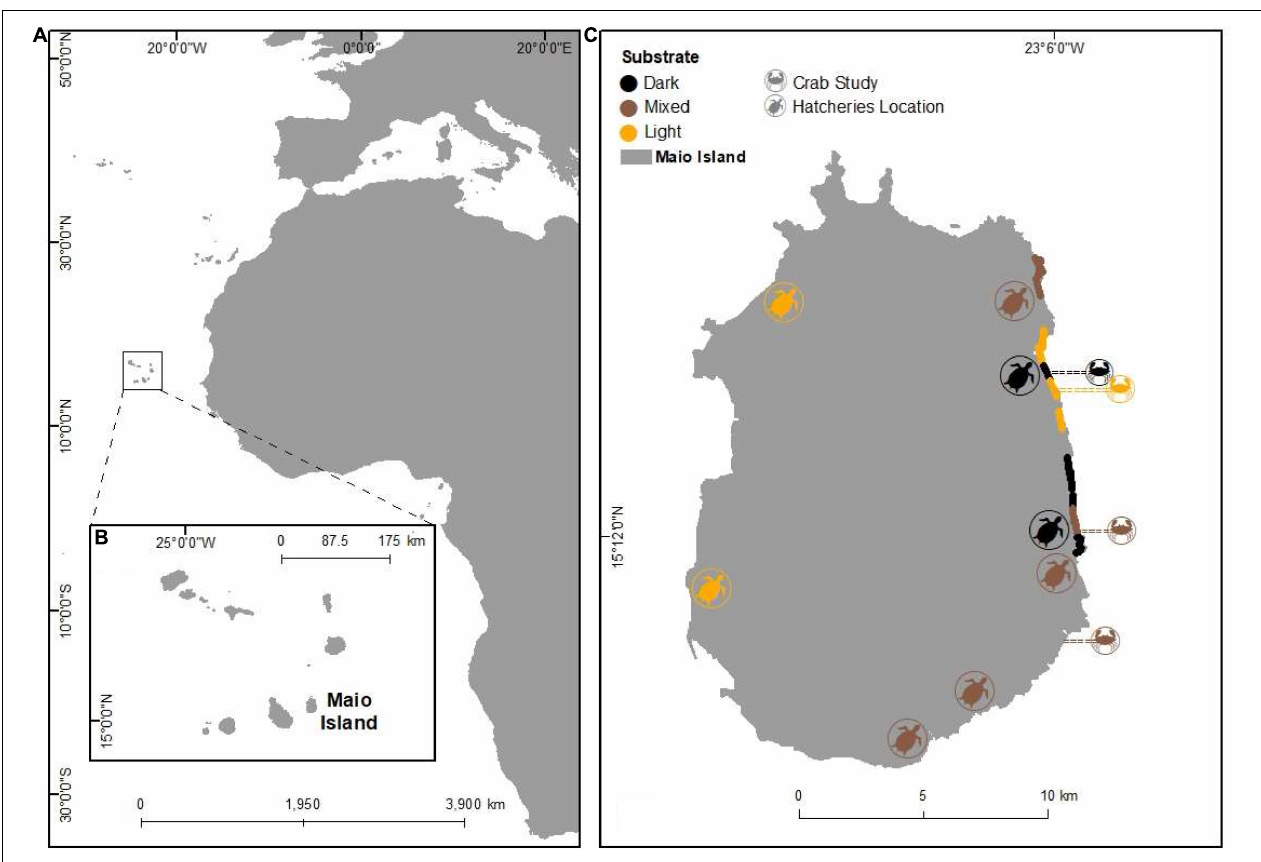
FIGURE 1 | Overview of the study sites. (A) Image of the Cabo Verde archipelago, West Africa. (B) Detailed map of the Cape Verde archipelago (inset). (C) Island of Maio ( C ; 15 ◦ 12 (cid:48) N—23 ◦ 6 (cid:48) W) showing the study areas by sand types (by colours) where loggerhead turtles nest. The crab symbol represents the location of the predator survey. Coloured lines (east coast) illustrate nest density and nesting success study